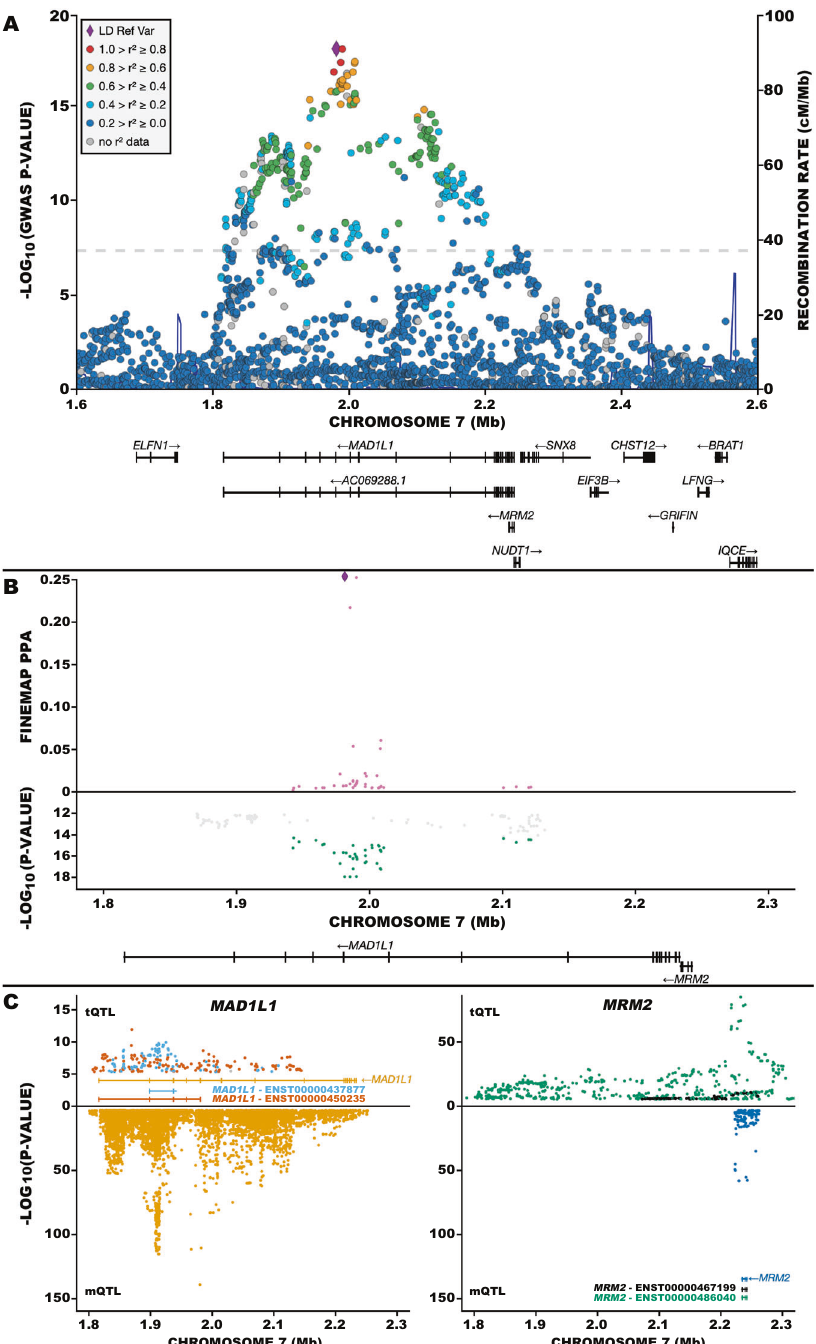
Fig. 3 Fine mapping and colocalization analysis at MAD1L1 -containing locus. A Negative log (base 10) p values for association at chromosome 7p22.3 from a genome-wide association study (GWAS) of schizophrenia [3]. The purple diamond represents SNP rs12668848 ( p = 1.110 × 10 − 18 ). Not shown: insertion/deletion variants. B Mirror plot of fi ne-mapping posterior probability (PPA; upper plot) and SZ associations (from A ) at chromosome 7p22.3 (lower plot). In the upper plot, the largest PPA was 0.254 (purple diamond). The remaining points are PPA computed on SZ-GWAS SNPs with association p < 5 × 10 − 15 . The lower plot shows SNPs with SZ association p <5 × 10 − 12 . The green points represent SNPs used for fi ne mapping because they have SZ association p < 5 × 10 − 15 ; SNPs not shown have negligible PPA. C Mirror plot of transcript quantitative trait loci (tQTL; upper plots) and methylation quantitative trait loci (mQTL; lower plots) for MAD1L1 (left) and MRM2 (right). The tQTLs and mQTLs were obtained from PsychENCODE [76] and Jaffe et al. [7], respectively. For MAD1L1 (upper left), 95 and 165, out of a total of 262 tQTL SNPs mapped to transcripts ENST00000437877 (teal points) and ENST00000450235 (red points), respectively. For MRM2 (upper right), 154 and 545, out of a total of 699 tQTL SNPs mapped to transcripts ENST00000467199 (black points) and ENST00000480040 (green points), respectively. In the lower half of each plot, mQTLs are depicted that show 11,368 mQTL SNPs mapping to 280 CpG sites associated with MAD1L1 (yellow points; lower left) and 129 mQTL SNPs mapping to 4 CpG sites associated with MRM2 (blue points; lower